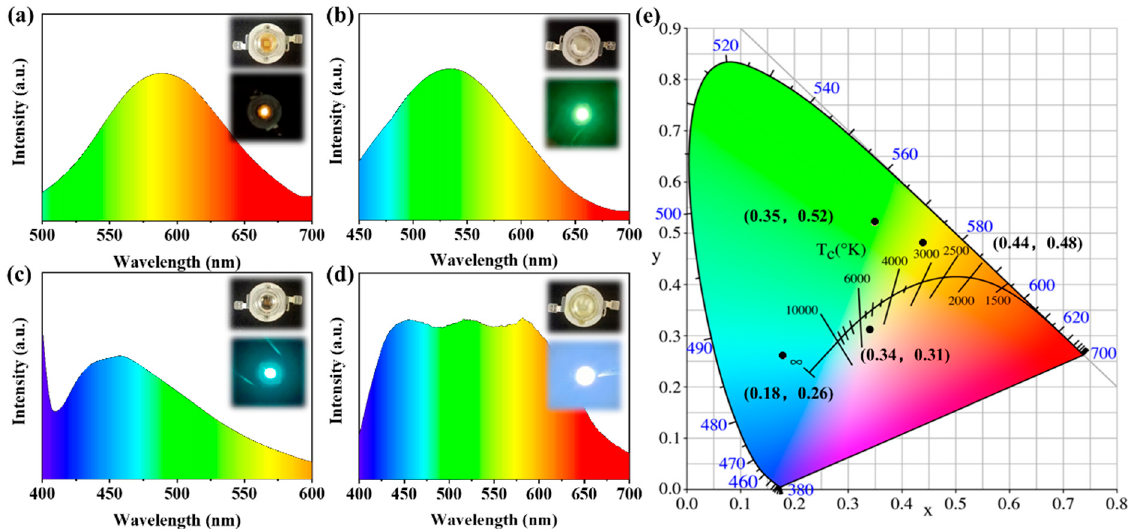
Figure 8. ( a – d ) EL emission spectra of the ( a ) O-LED, ( b ) G-LED, ( c ) B-LED and ( d ) WLED. The insets show optical images of the LEDs in the “off” ( top ) and “on” ( bottom ) states. Note: The color change in the picture corresponds to the dispersion spectrum of visible light at the corresponding wavelength. ( e ) CIE 1931 diagram containing the colour coordinates of the O-LED, G-LED, B-LED and WLED devices.